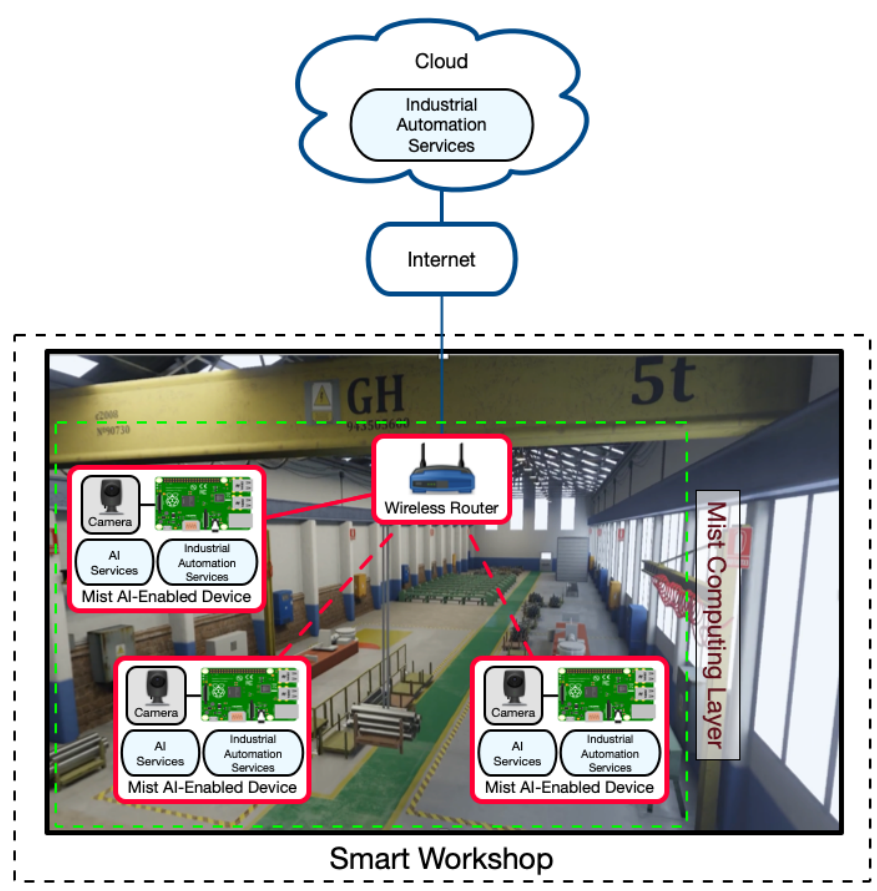
Figure 10. Mist-computing-based communications